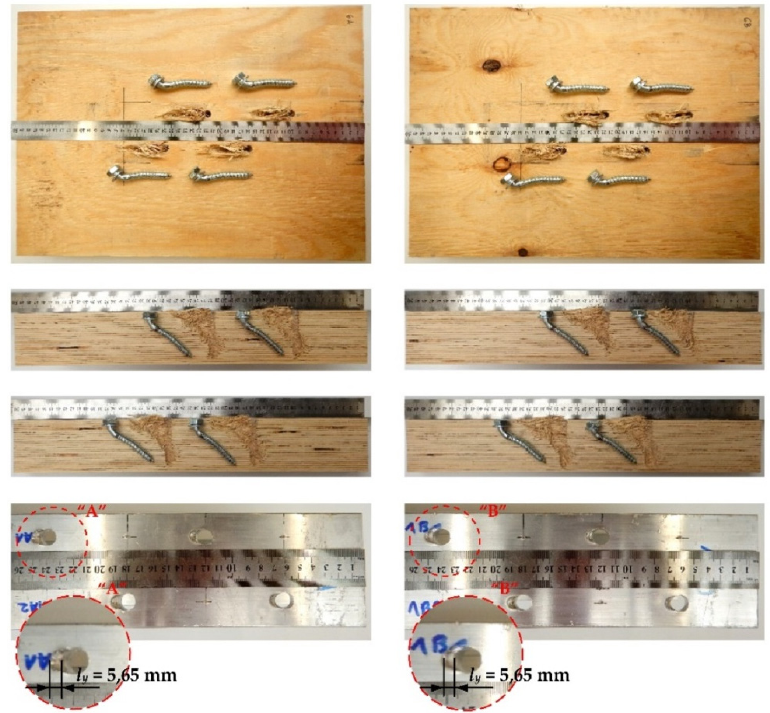
Figure 12. The mode of failure of the aluminium-timber connection with the 12 mm screws and without the reinforcing toothed plates.